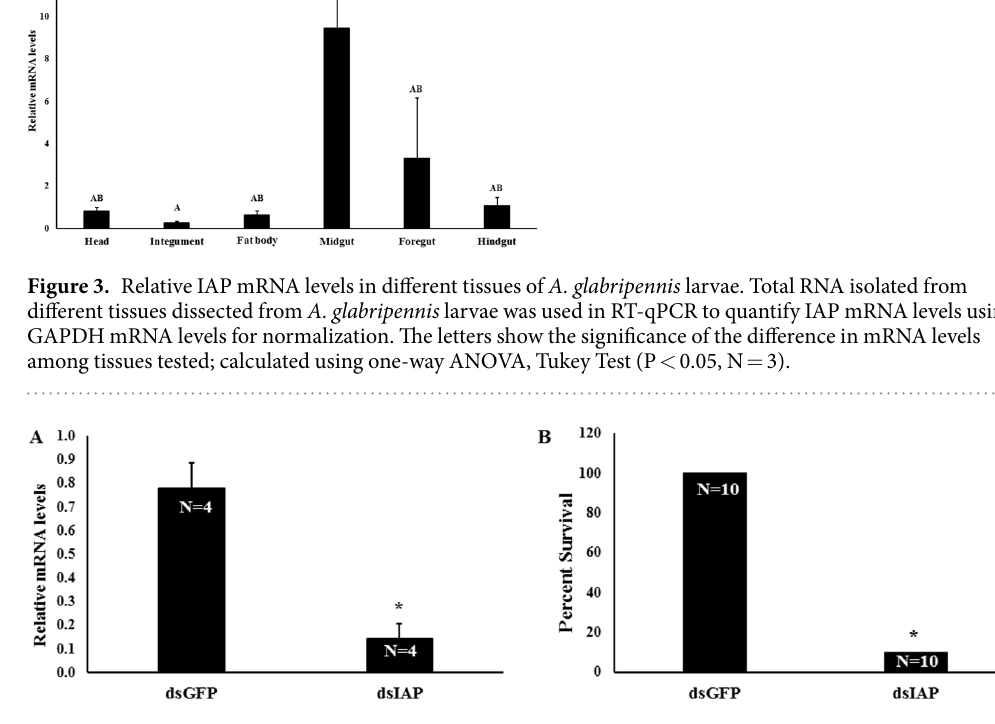
Figure 4. RNAi response in A. glabripennis larvae. ( A ) IAP mRNA levels on 5 th day after dsIAP injection. Total RNA isolated from A. glabripennis larvae injected with dsGFP or dsIAP was used in RT-qPCR to quantify IAP mRNA levels using GAPDH mRNA levels for normalization. The asterisk indicates significant differences in mRNA levels (t-test, one-tailed, P-value 0.001, N = 4). ( B ) Survival rate (%) on 10 th day after injection of dsRNA. The asterisk indicates significant differences in mortality between treatment and control (Fisher’s Exact test, Two-tailed, P-value < 0.001, N = 10).